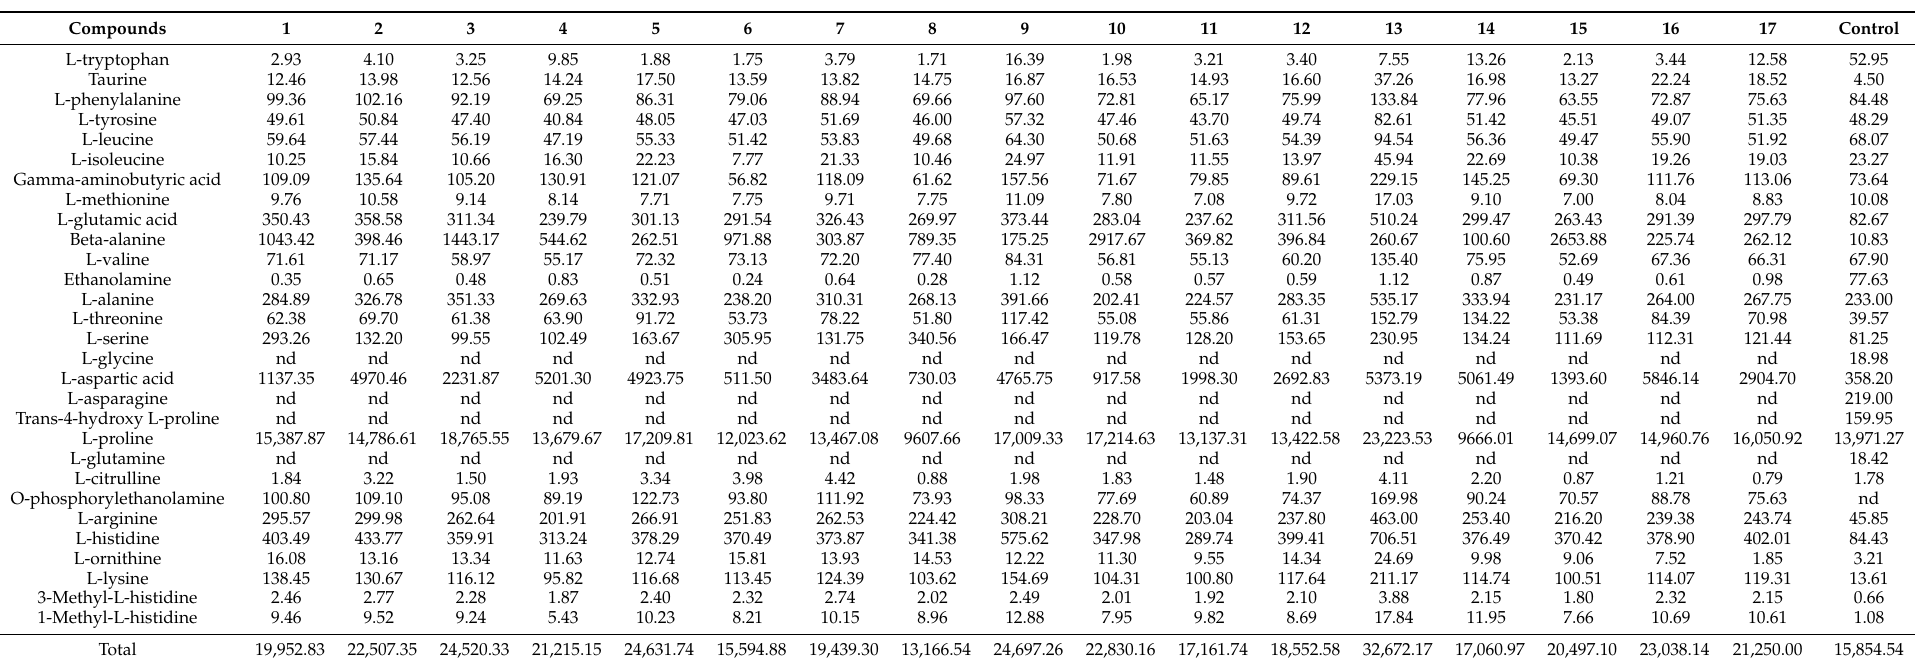
Table 4. Amino acid contents of bee pollen extracts